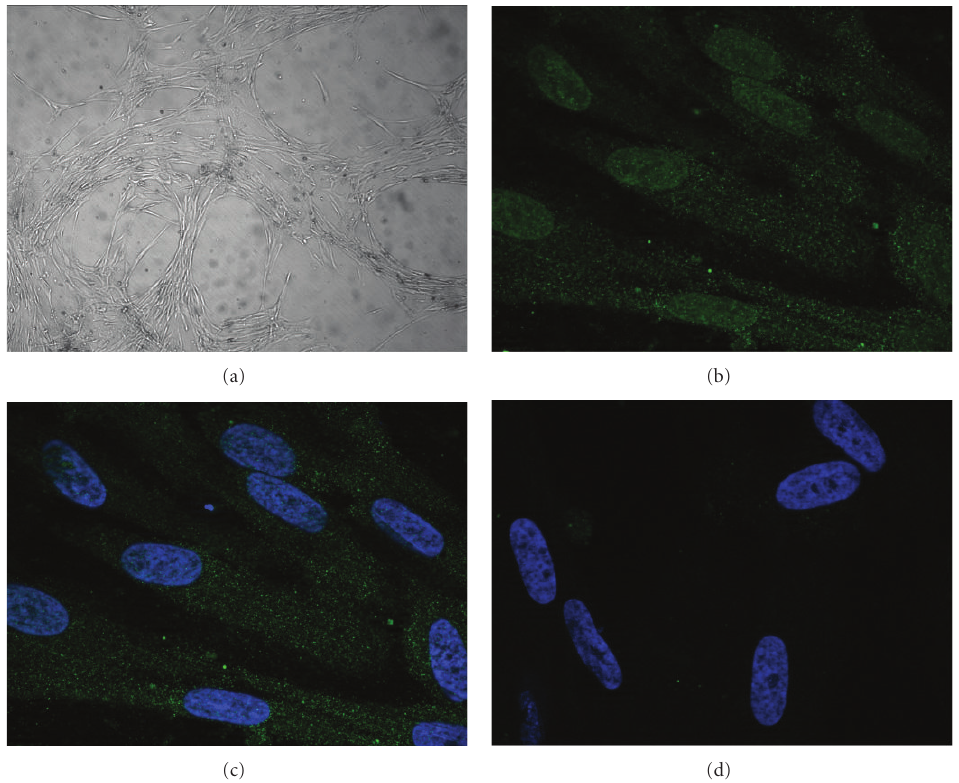
Figure 6: Myogenic di ff erentiation. Phase contrast microscopy of cultures grown in myogenic medium for 21 days (a) at low magnification, immunofluorescence for myogenin in cells cultured in myogenic medium for 21 days; (b) myogenin stained with primary antibody against and with a secondary antibody anti-mouse (conjugated with Alexa Fluor 488); (c) merged with DAPI (blue, nuclei); (d) negative control with DAPI and secondary antibody